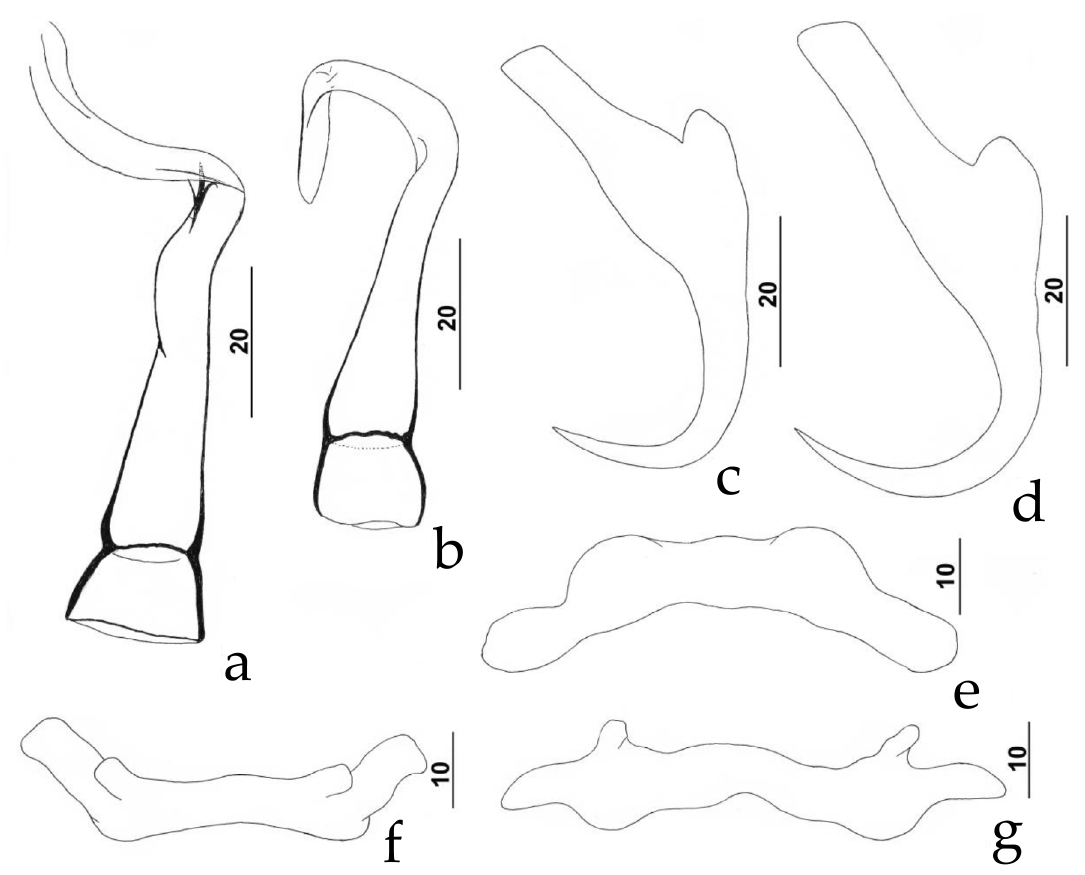
Figure 5. Platycephalotrema macassarensis (Yamaguti, 1963) n. comb. ( a–b ). male copulatory organs (ventral views); ( c ). dorsal anchor; ( d ). ventral anchor; ( e ). ventral bar; ( f–g ). dorsal